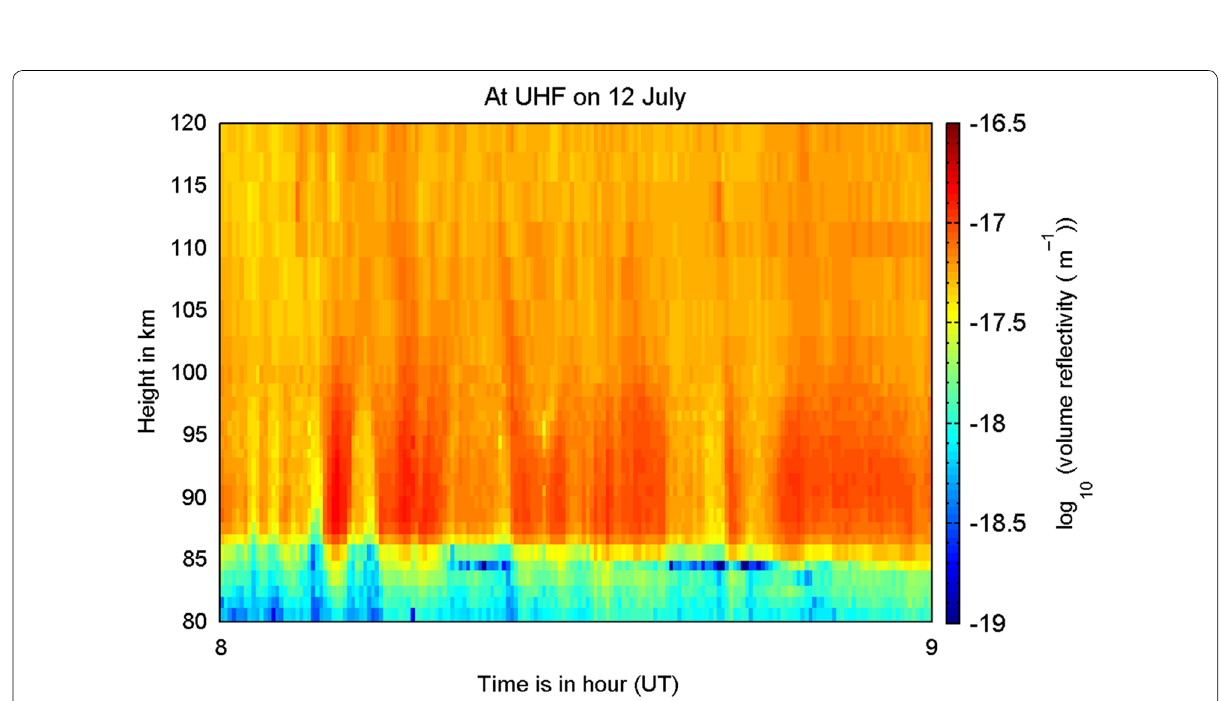
Fig. 12 UHF radar observations for the corresponding VHF radar observation (8–9 UT) of Fig.